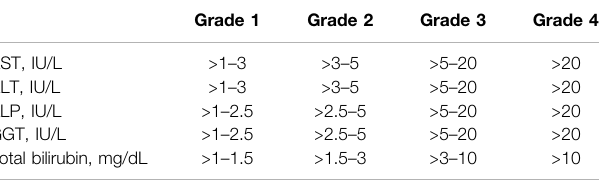
TABLE 3 | Common Toxicity Criteria for Adverse Events (CTCAE) of the National Cancer